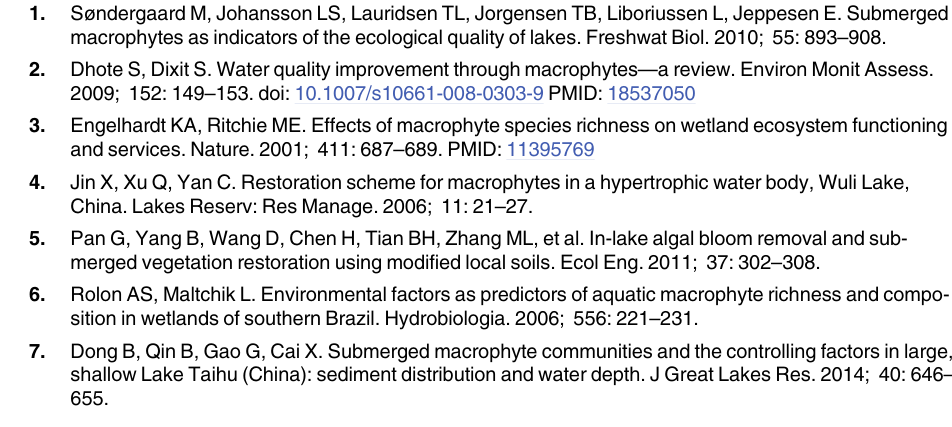
S1 Table. Data used from the experiment in analyses. (XLSX)